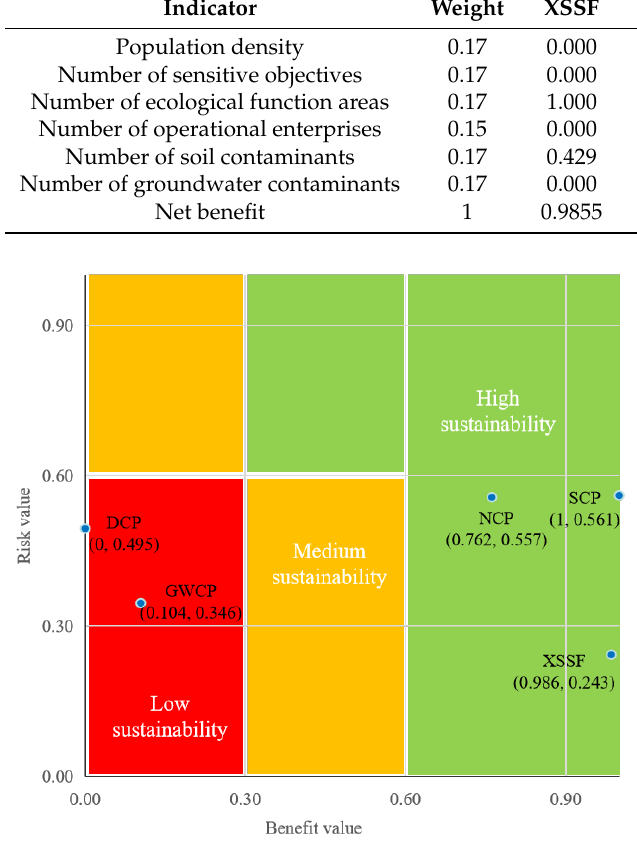
Figure 4. Sustainability performance of the contaminated sites’ risk